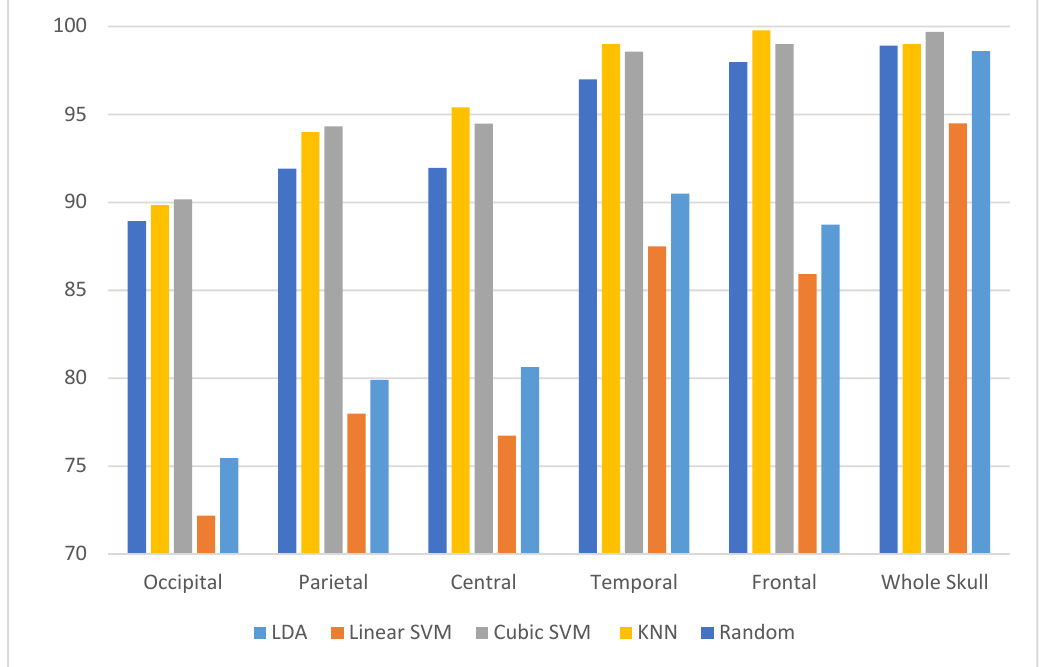
Figure 11. A comparison between classification accuracies of several classifiers constructed using the proposed Feature-Set 3 extracted from different sites on the skull to access stress levels. Table 6. Accuracy (95% CI) for evaluating stress levels from different electrode sites .